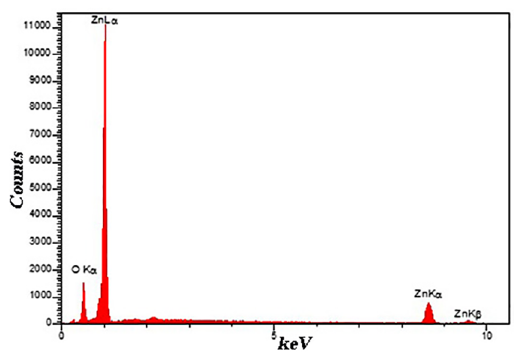
Figure 5. EDX spectrum measured for undoped zinc oxide thin films prepared at optimum temperature 450℃ Table 2. Quantitative EDX results for undoped zinc oxide thin films prepared at optimum temperature 450°C.